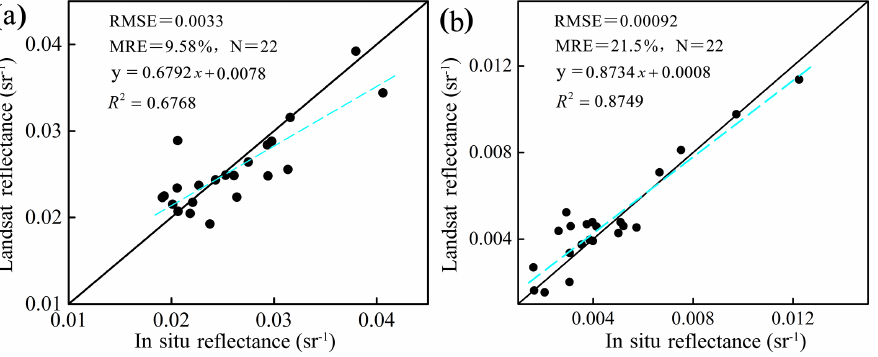
Figure 6. Scatter plot of Landsat measured reflectance vs. in situ reflectance. The former is calculated by averaging over a box of 3 × 3 pixel centered samples. (a) Red band; (b) near-infrared band.